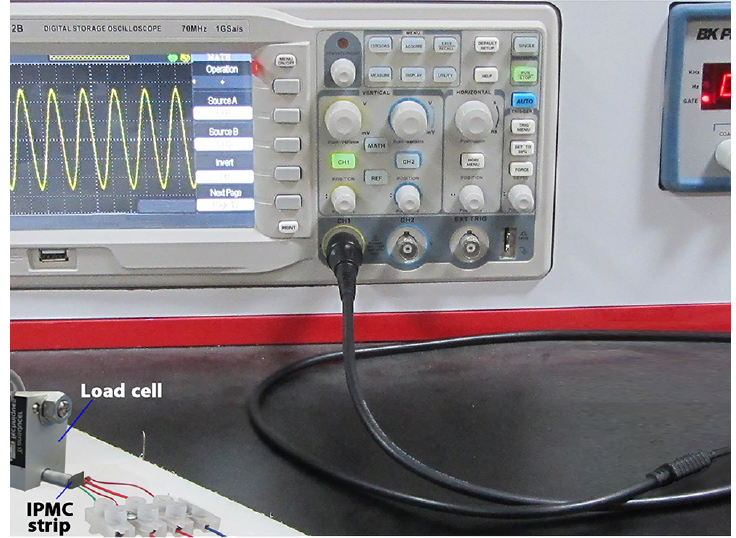
Figure 5. Devices for experimental force measurement.